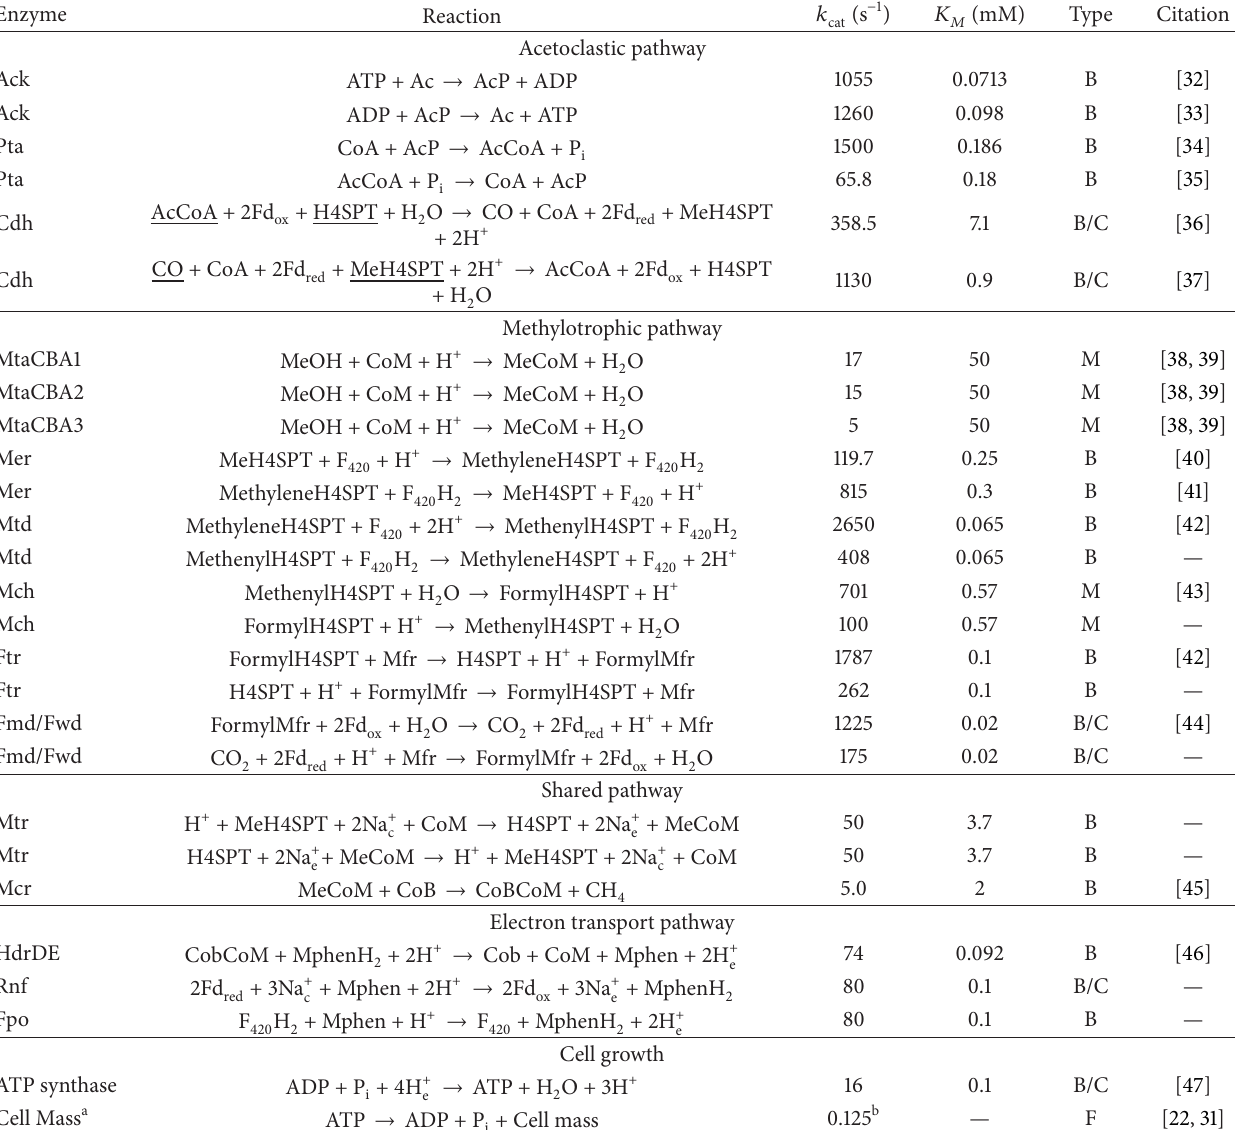
Table 1: Kinetic model of methanogenesis. Reactions are from iMB745 [22]. Rate constants used in the kinetic model are taken from the literature where indicated or were fit to experiments of growth on methanol. Water molecules and the intracellular protons (H + ), which are shown for completeness, are assumed to be constant and are not explicitly modeled. The “Type” column specifies the reaction mechanism: B: irreversible bimolecular Michaelis-Menten, B/C: irreversible bimolecular Michaelis-Menten for the two underlined reactants with a constant flux term for the others, which is set to the flux calculated for bimolecular reaction, M: irreversible unimolecular Michaelis-Menten, F: first order